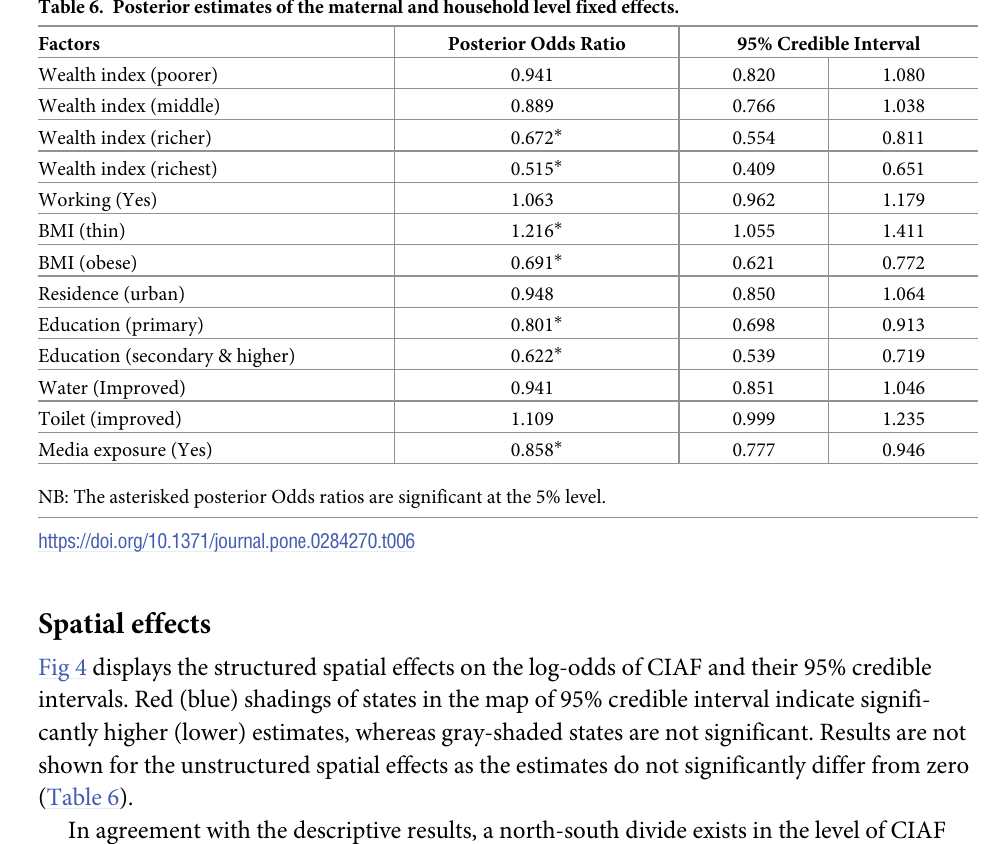
Table 6. Posterior estimates of the maternal and household level fixed effects.